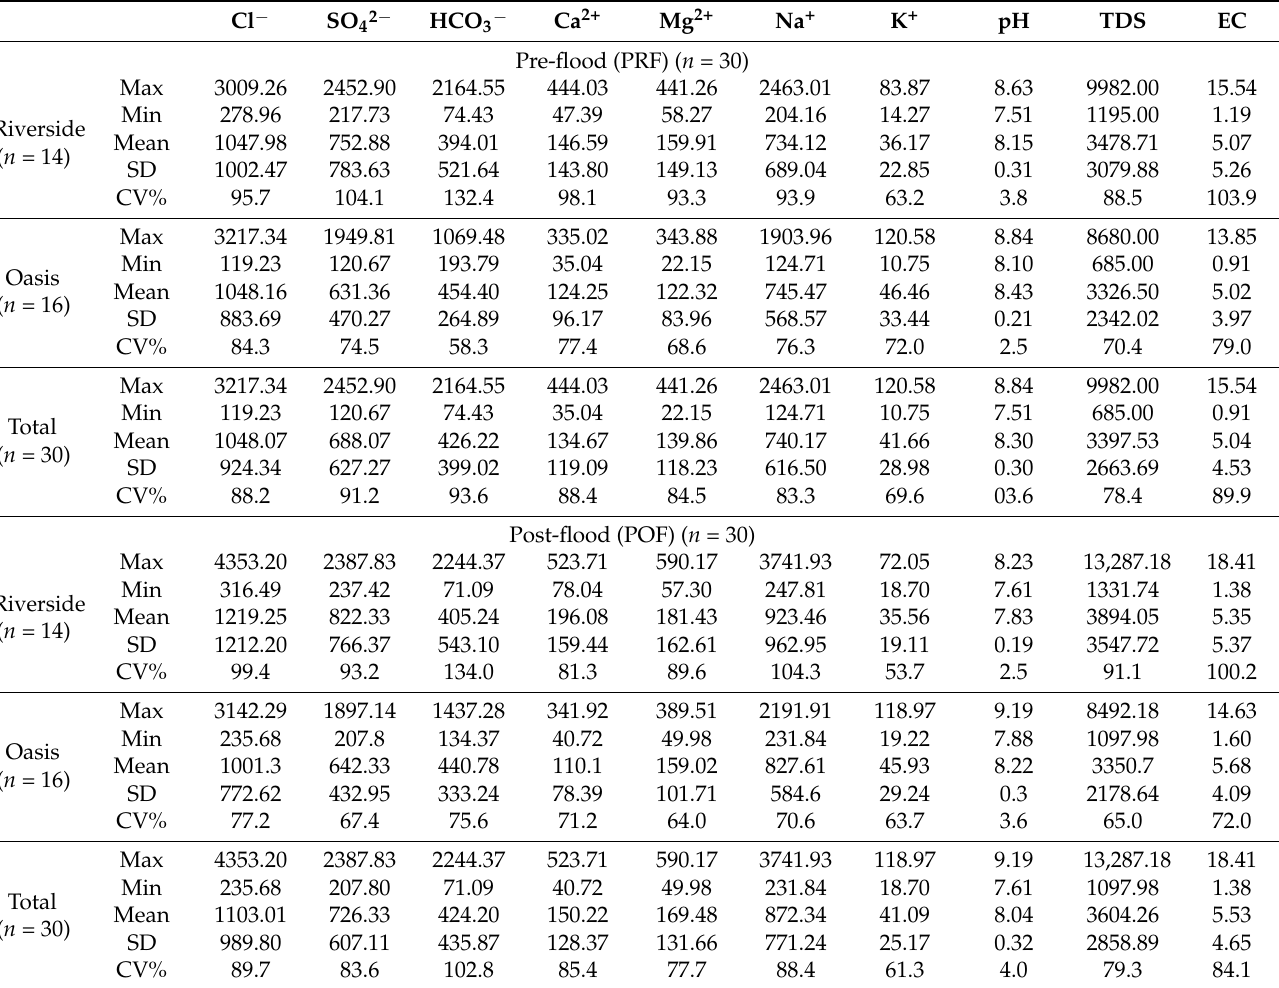
Table 2. Descriptive statistics of the hydrochemical parameters of groundwater in the study